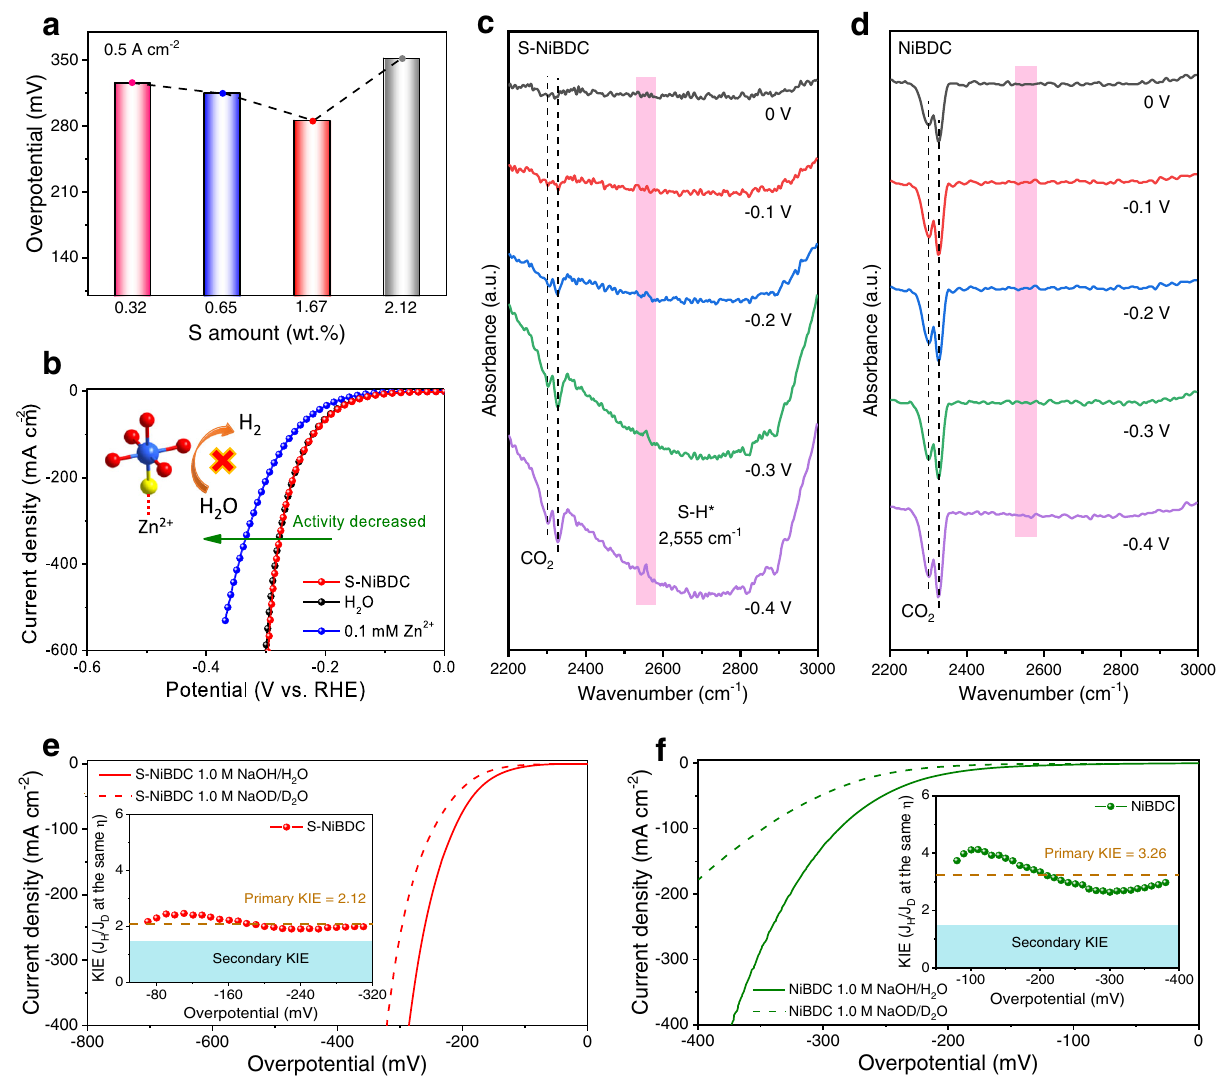
Fig. 5 | Mechanism analyses of accelerated HER kinetics. a Overpotentials at 0.5Acm − 2 for S-NiBDC samples with different S doping amounts. b Polarization curves of S-NiBDC before and after soaking in 0.1mM Zn(NO 3 ) 2 solution and H 2 O.